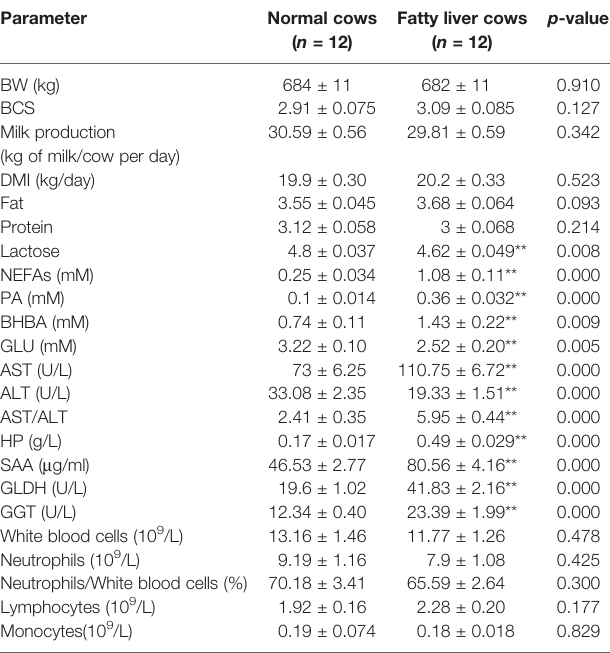
TABLE 1 | The biochemical parameters and clinical characteristics of normal and fatty liver dairy cows. Parameter Normal cows